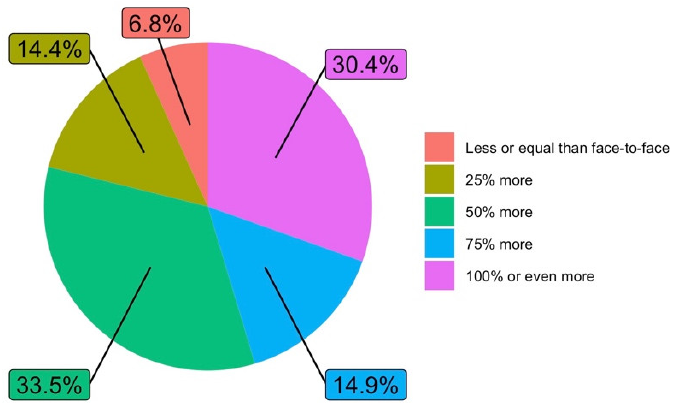
Figure 5. Workload of virtual teaching compared to face-to-face teaching (answers to Q2).